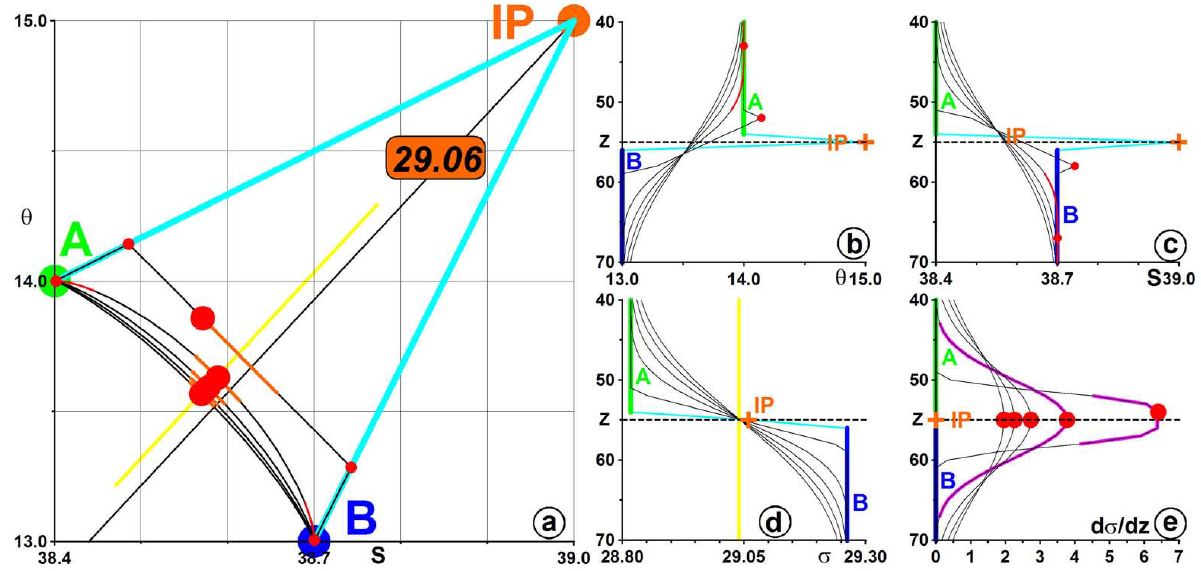
Fig. 3. – a) as in Figure 1 except for the thickness of the intermediate layer (9 depth units for IW, 1 for IP). Mixing reaches the IP core as soon as time step 1 (which was not the case for the IW core), creating clearly identified q and S maxima. Such maxima then occur only at time step 2, as indicated by the red parts of the corresponding profile and the red small dots located nearly over the A and B points. The big red dots indicating the d s /dz maxima are rapidly associated with the ( s (A)+ s (B))/2 value. b) and c) allow the immersion of the q and S maxima to be specified and emphasize their relatively rapid migration away from their initial location. d) inflection points of the s profiles occur at the depth of the initial IP core. e) d s /dz profiles rapidly become symmetric with respect to the initial immersion of the IP